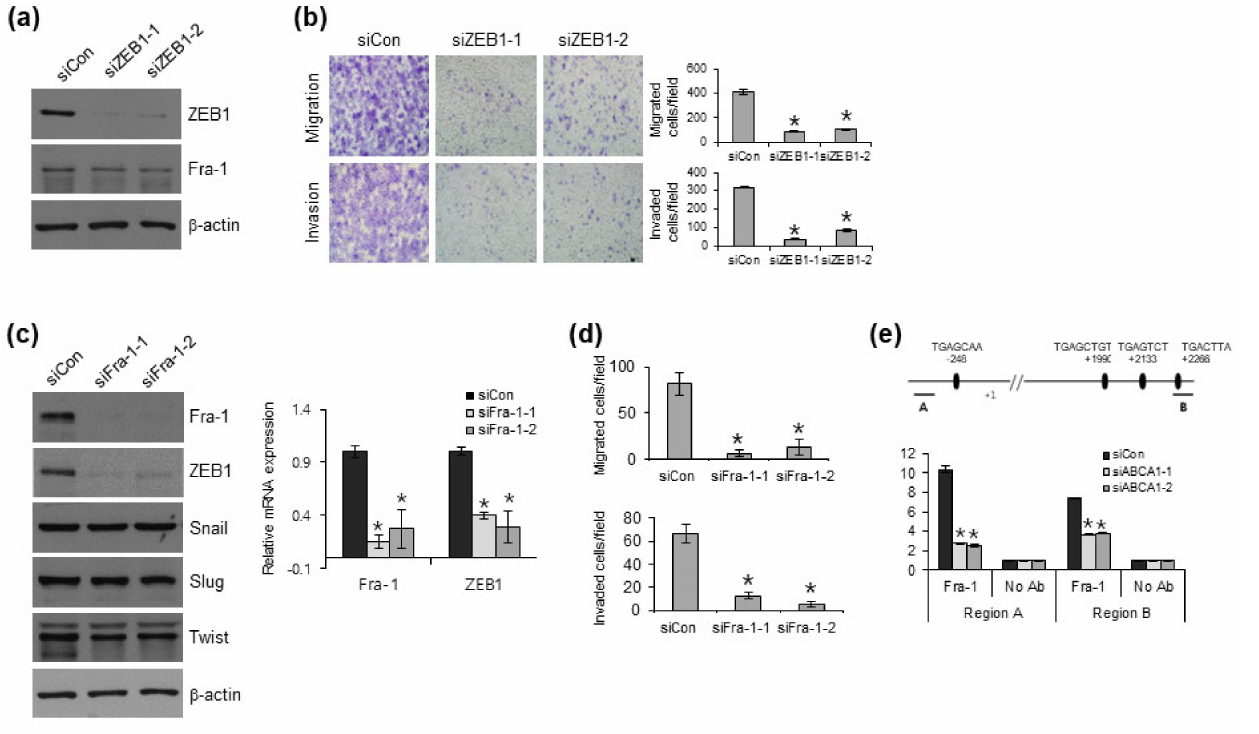
Figure 5. Knockdown of ABCA1 expression suppresses ZEB1 expression via ERK/Fra-1. ( a ) Effect of ZEB1 on Fra-1 expression was analyzed via Western blotting. ( b ) Representative images and quantification of migration (upper) and invasion (lower) by the indicated cells. The data represent the means ± S.D. of triplicate assays. * p < 0.05, compared with siCon (Student’s t -test). ( c ) Effect of Fra-1 on ZEB1 expression was analyzed via Western blotting (left) and qRT-PCR (right). ( d ) Graphs show the migration (upper) and invasion (lower) abilities of siRNA-mediated Fra-1-knocked-down BCPAP cells. ( e ) ChIP analysis showing the recruitment of Fra-1 to the promoter regions of ZEB1 gene in ABCA1-knocked-down BCPAP cells. Results are shown as means ± S.D. of experiments